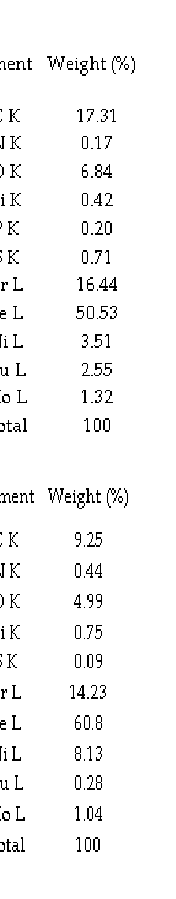
Figure 19. EDS analysis under various input parameters.